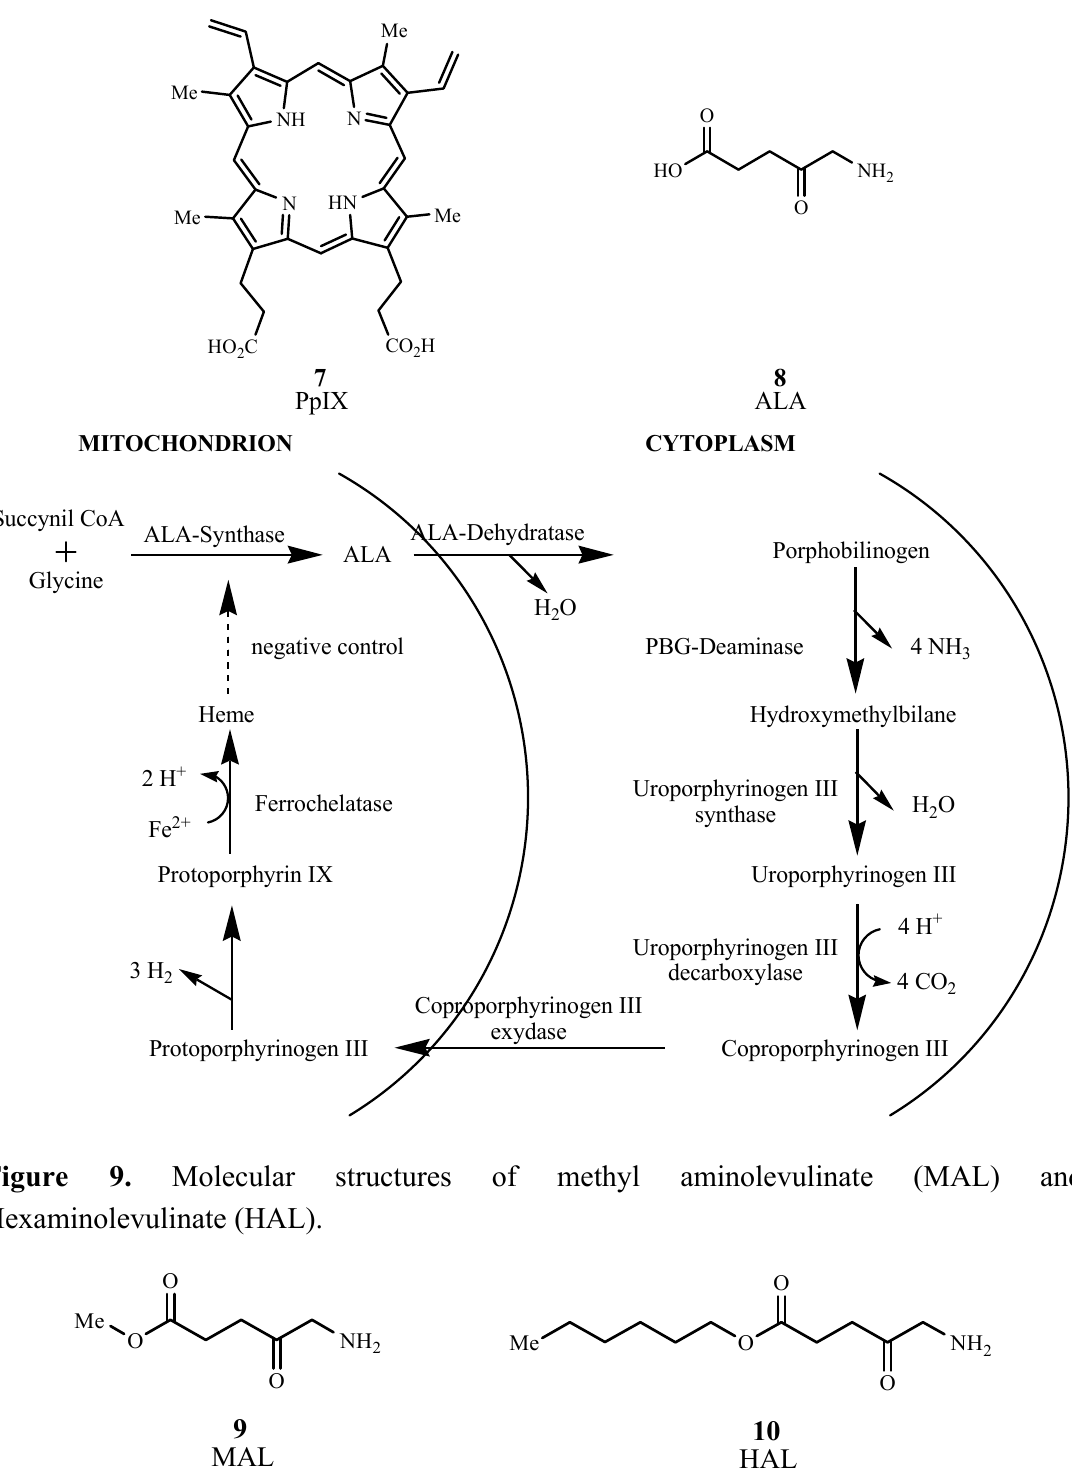
Figure 8. Pathway for heme biosynthesis.